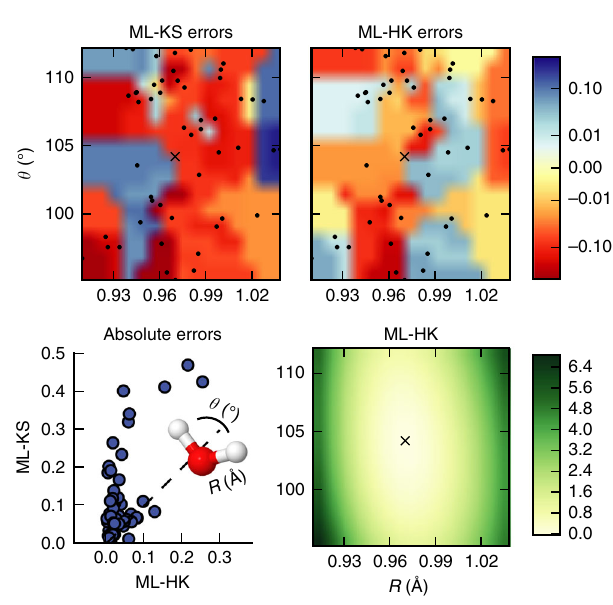
Fig. 2 Result of the comparison for H 2 O. ( Top ) Distribution of energy errors against PBE on the H 2 O data set for ML-KS and ML-HK. The errors are plotted on a symmetric log scale with a linear threshold of 0.01, using nearest neighbor interpolation from a grid scan for coloring. Black dots mark the test set geometries with averaged bond lengths. ( Bottom left ) Comparison of the PBE errors made by ML-HK and ML-KS on the test set geometries. ( Bottom right ) Energy landscape of the ML-HK map for symmetric geometries ( R vs. θ ). All models were trained on M = 15 training points. Energies and errors in kcal/mol. A black cross marks the PBE equilibrium